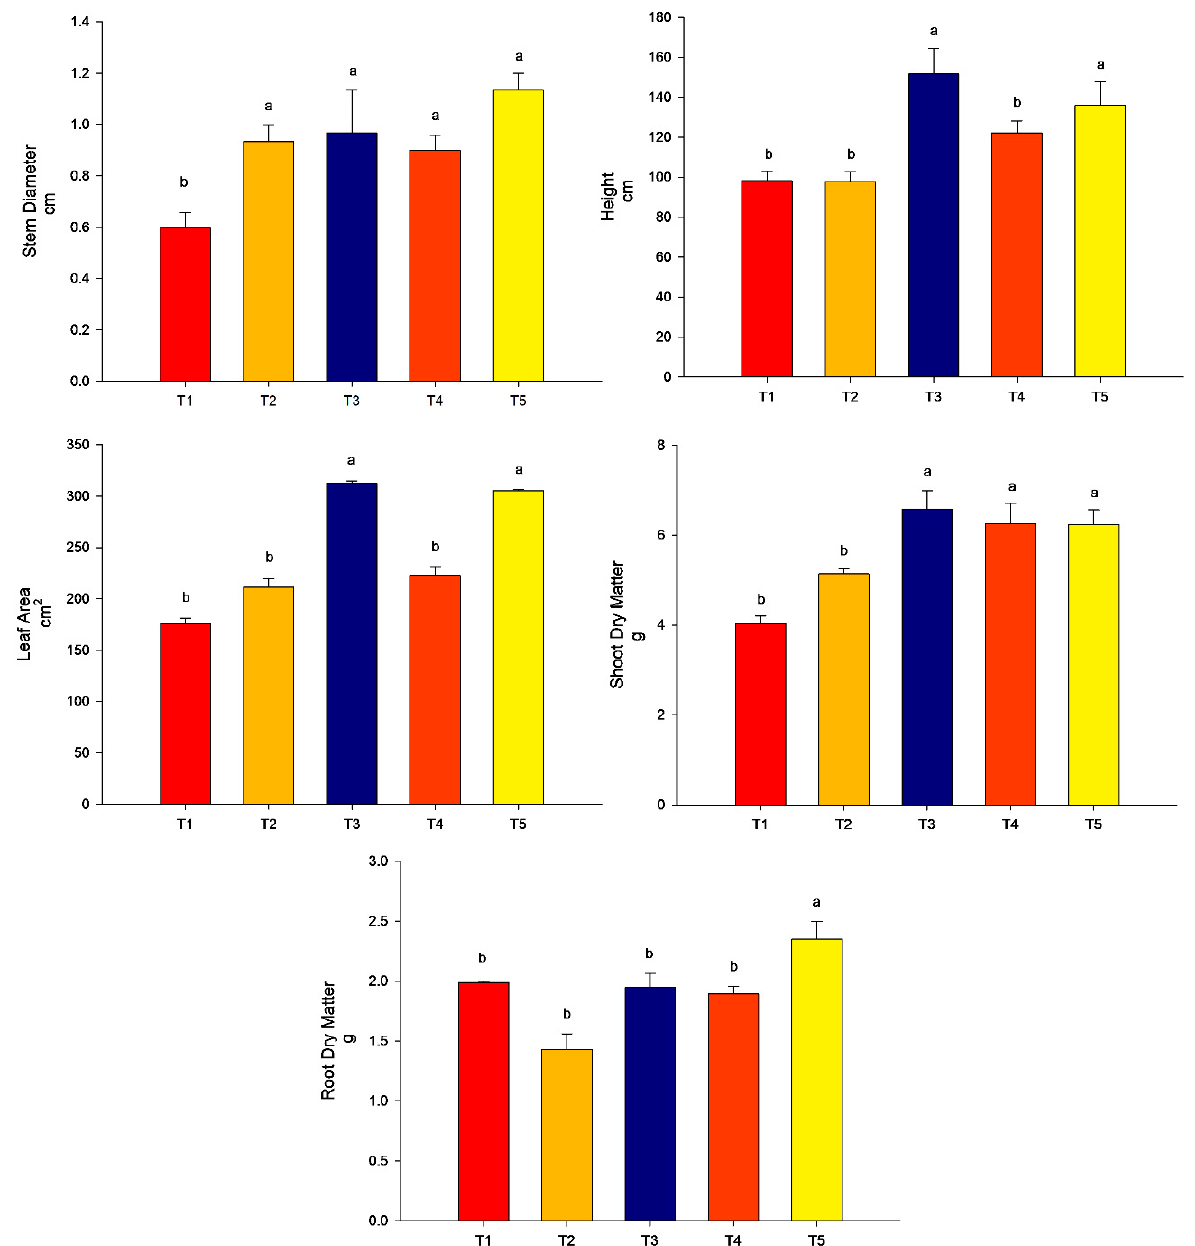
Figure 4. Agronomic analyses were performed on maize plants (40 DAE) with the combination of B. subtilis , rock powder, and conventional fertilization (experiment 2). Means followed by the same letter on the line do not differ from each other by the Scott ‒ Knott test at 5%. T1 = control—conventional fertilization (100%); T2 = conventional fertilization (100%) + rock powder; T3 = conventional fertilization (100%) + B. subtilis ; T4 = conventional fertilization (100%) + rock powder + B. subtilis ; T5 = conventional fertilization (50%) + rock powder + B. subtilis . Bars mean = standard error. Different lowercase letters mean significant statistical dif ‐